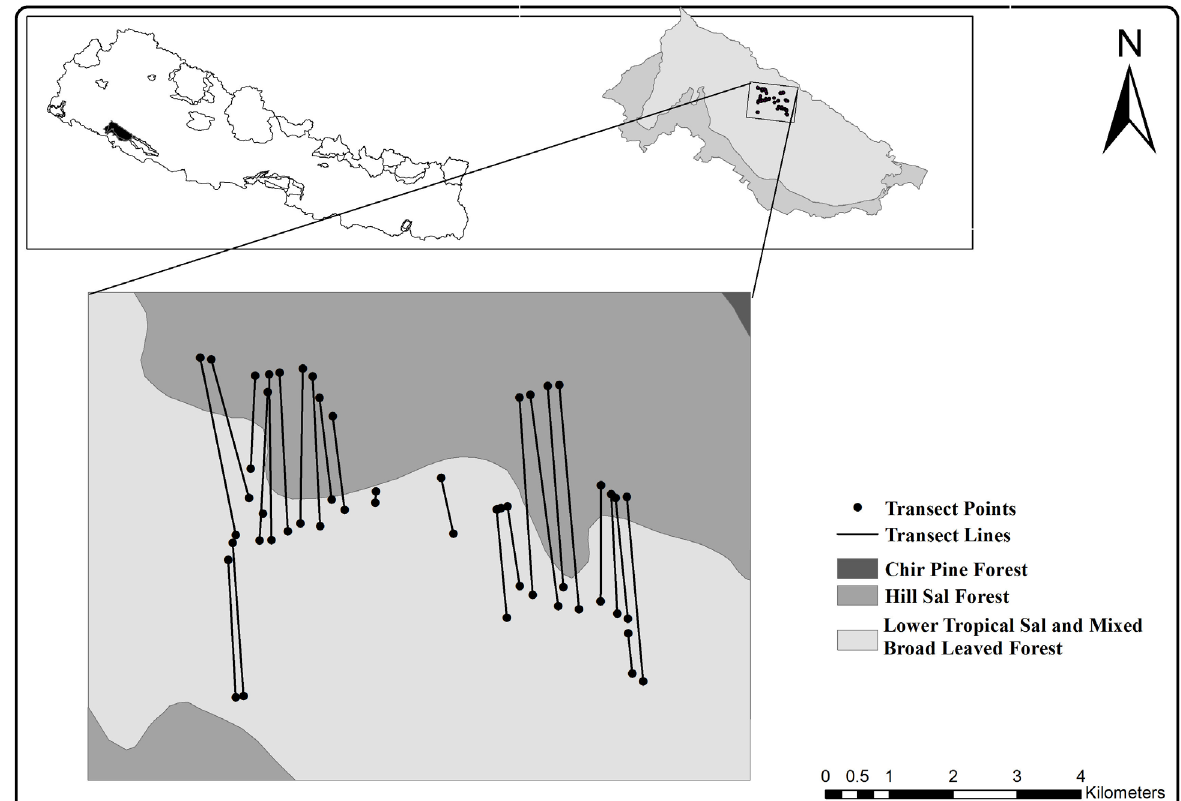
Figure 1. Map Showing Bardia National Park, Nepal and survey line transects inside the